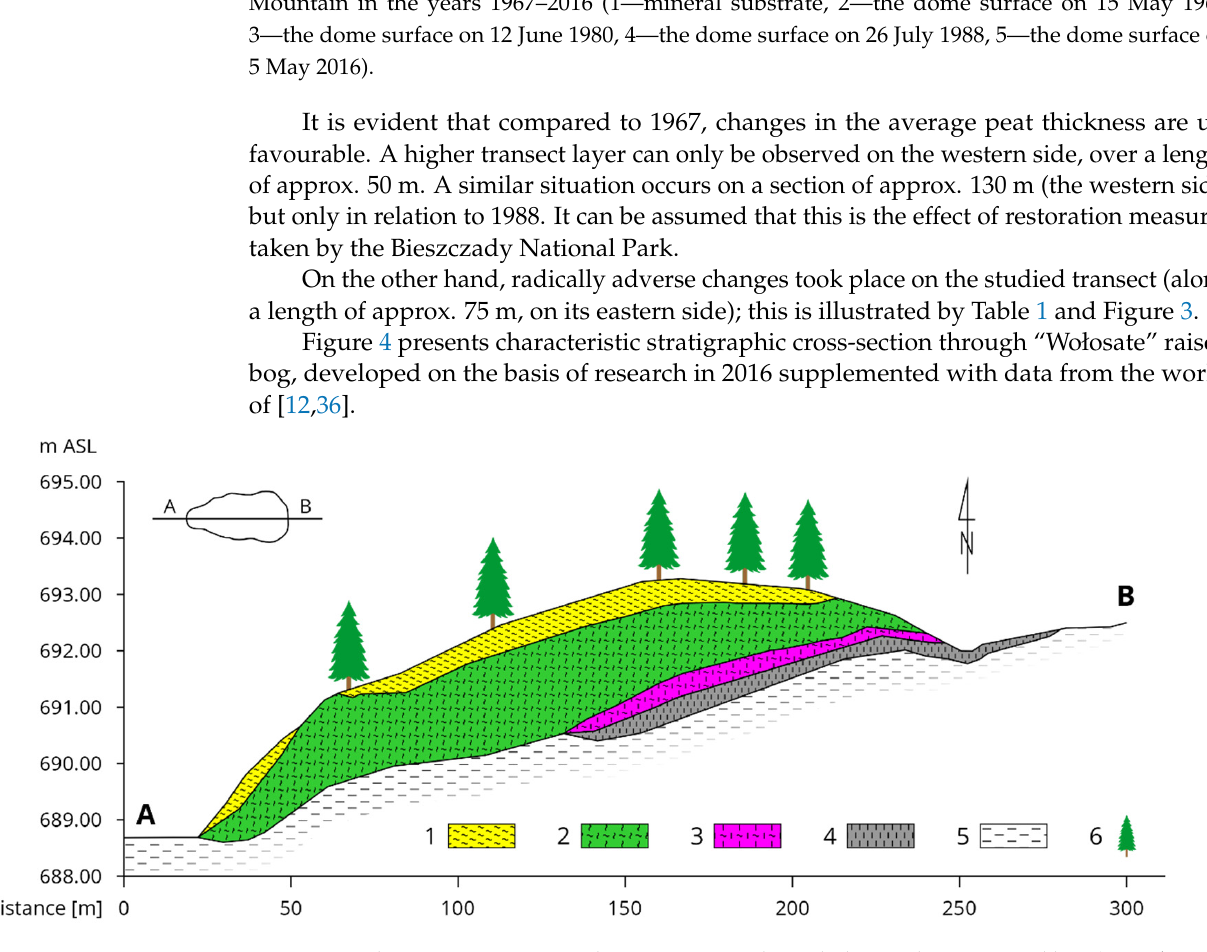
Figure 4. A characteristic stratigraphic A-B transect through the “Wołosate” raised bog (1— Sphagnum peat growing in tufts ( Eusphagneti ), 2—cottongrass and Sphagnum peat ( Eriophoro-Sphagneti ), 3—Sphagnum and sedge peat ( Sphagno-Cariceti ), 4—woody alder peat ( Alneti ) with degree of decom- position R > 60%, 5—clayey formation, 6—European spruce Picea abies